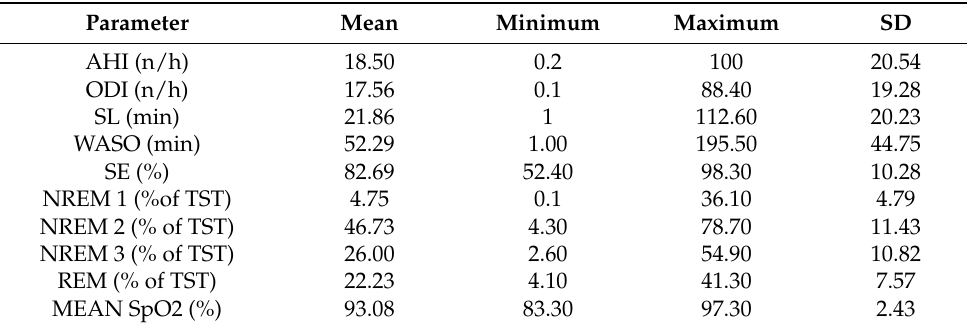
Table 1. Polysomnographic data of the study sample and telomere length.